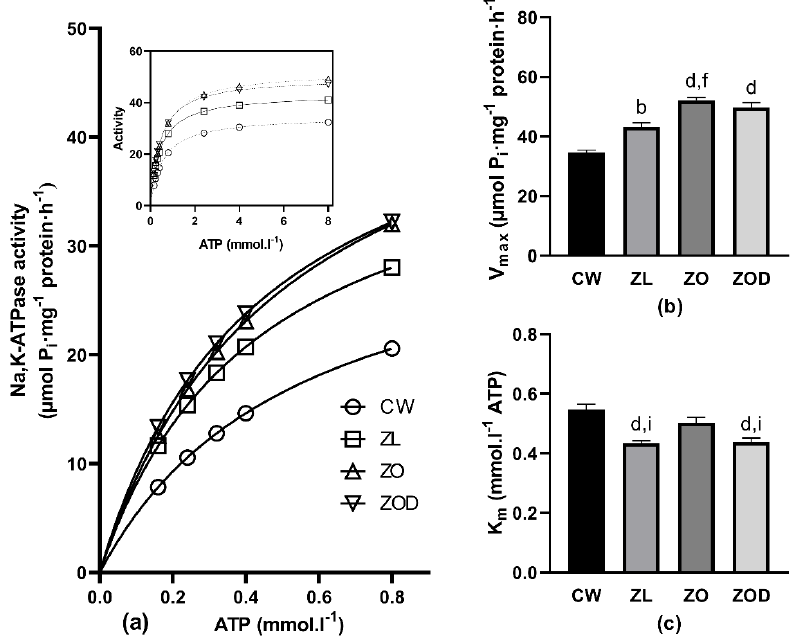
Figure 2. Activation of the Na,K-ATPase enzyme by substrate ATP in the renal cortex. (Panel a ) Activation of the Na,K-ATPase by low concentrations of substrate ATP. Inset: activation of the enzyme in the whole investigated concentration range of ATP in Wistar rats (CW, n = 8), lean fa/+ (ZL, n = 8), and Zucker diabetic fatty (ZDF) fa/fa rats divided into ZO (ZDF fa/fa obese, glycemia < 10 mmol · L − 1 , n = 8) and ZOD (ZDF fa/fa obese diabetic, glycemia > 10 mmol · L − 1 , n = 8) groups. Error bars are not depicted, as they are shorter than the size of the symbols. (Panel b ) V max values in all experimental groups. (Panel c ) K m values in all experimental groups. The animals were sacrificed at the age of 38–39 weeks. Data represent means ± standard errors of mean. For statistical analyses, one-way analysis of variance with Tukey’s post hoc test was used: b: p < 0.01, d: p < 0.0001 vs. CW; f: p < 0.01 vs. ZL; i: p < 0.05 vs. ZO.